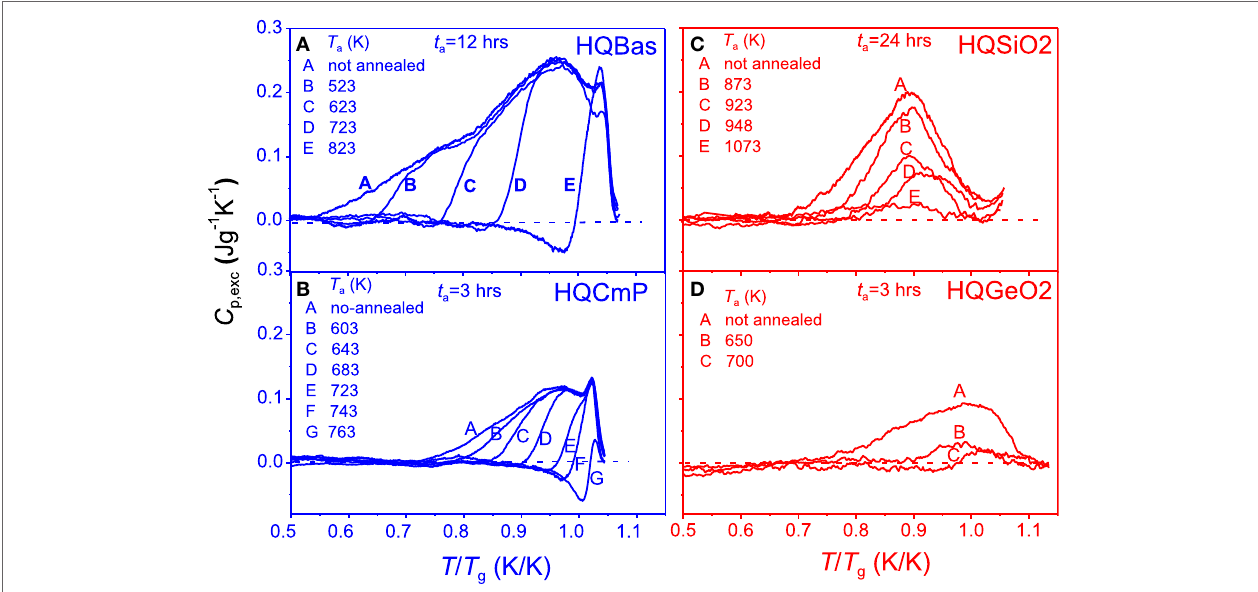
FigUre 5 | effect of the annealing temperature T a on the C p,exc as a function of T / T g for a given annealing duration t a . The T g values are given in Table 1 . Left panel (fragile systems): (a) HQBas (Yue et al., 2002a); (B) HQCmP (Yue, 2002). Right panel (strong systems): (c) HQSiO 2 containing 1021 ppm hydroxyl (this work); (D) HQGeO 2 (Hornbøll and Yue, 2008b). The dashed lines represent the C p,exc peak (as reference) obtained on the samples cooled at 20